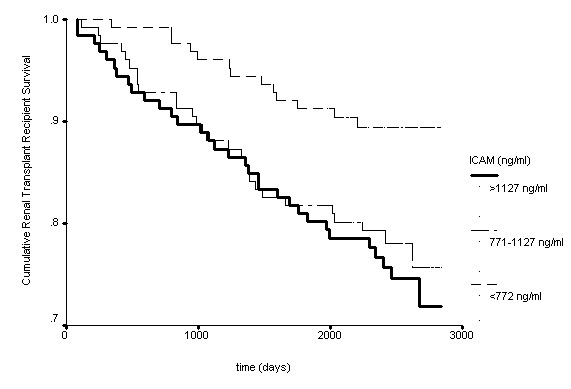
Kaplan-Meier survival curve for renal transplant recipients stratified by ICAM concentration banded into thirds (p = 0.009).